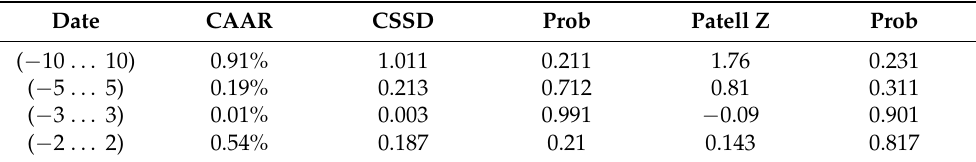
Table 6. Results of parametric tests (other than the US and UK).